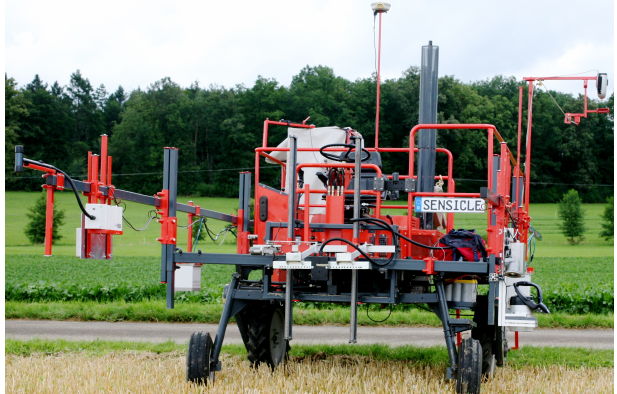
Figure 2. The multi-sensor platform “Sensicle” with the mounted